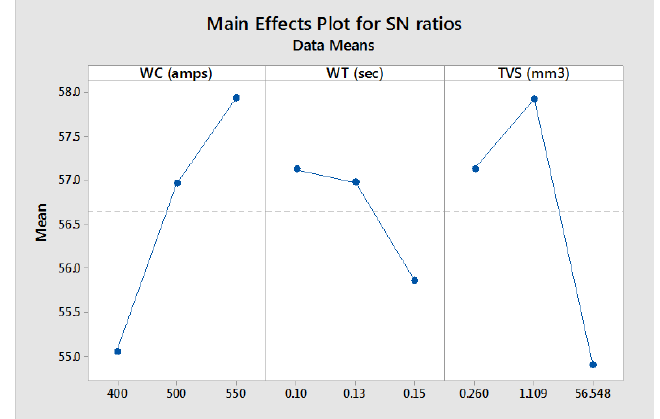
Figure 9. Main effect plot for means of tensile strength.